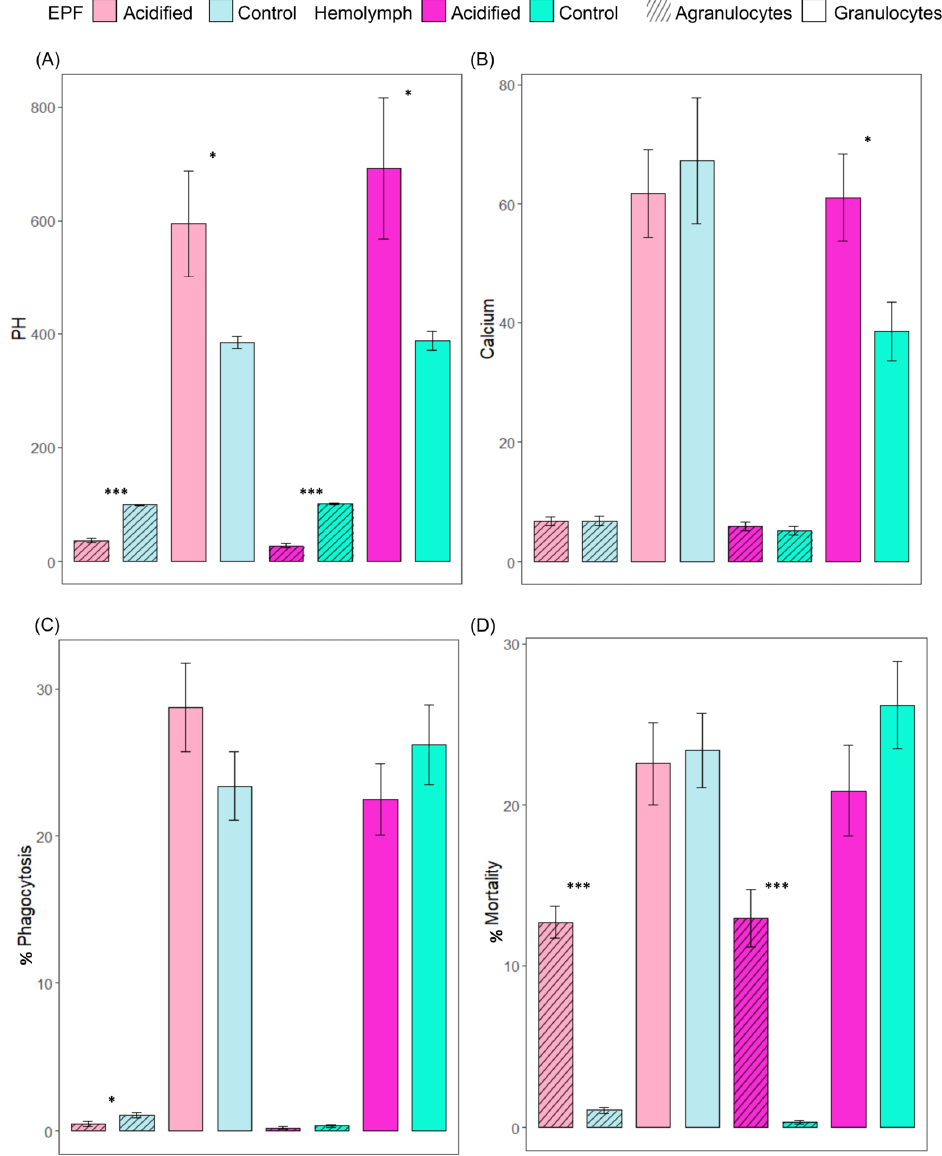
Figure 2. Relative fluorescence intensity of ( A ) BCECF-AM (indicator of intracellular pH) and ( B ) Fluo-3 (indicator of Ca 2+ ), and phagocytic activity ( C ) for agranulocytes and granulocytes from EPF and hemolymph. ( D ) Cell mortality (% of PI-positive cells). Shades of pink: acidified; shades of blue: control; lighter shades: EPF; darker shades: hemolymph; diagonal lines: agranulocytes; plain bars: granulocytes. Nested ANOVAs; n = 4; means ± standard errors; asterisks denote significant differences between acidified and control clams (* <0.05; ***